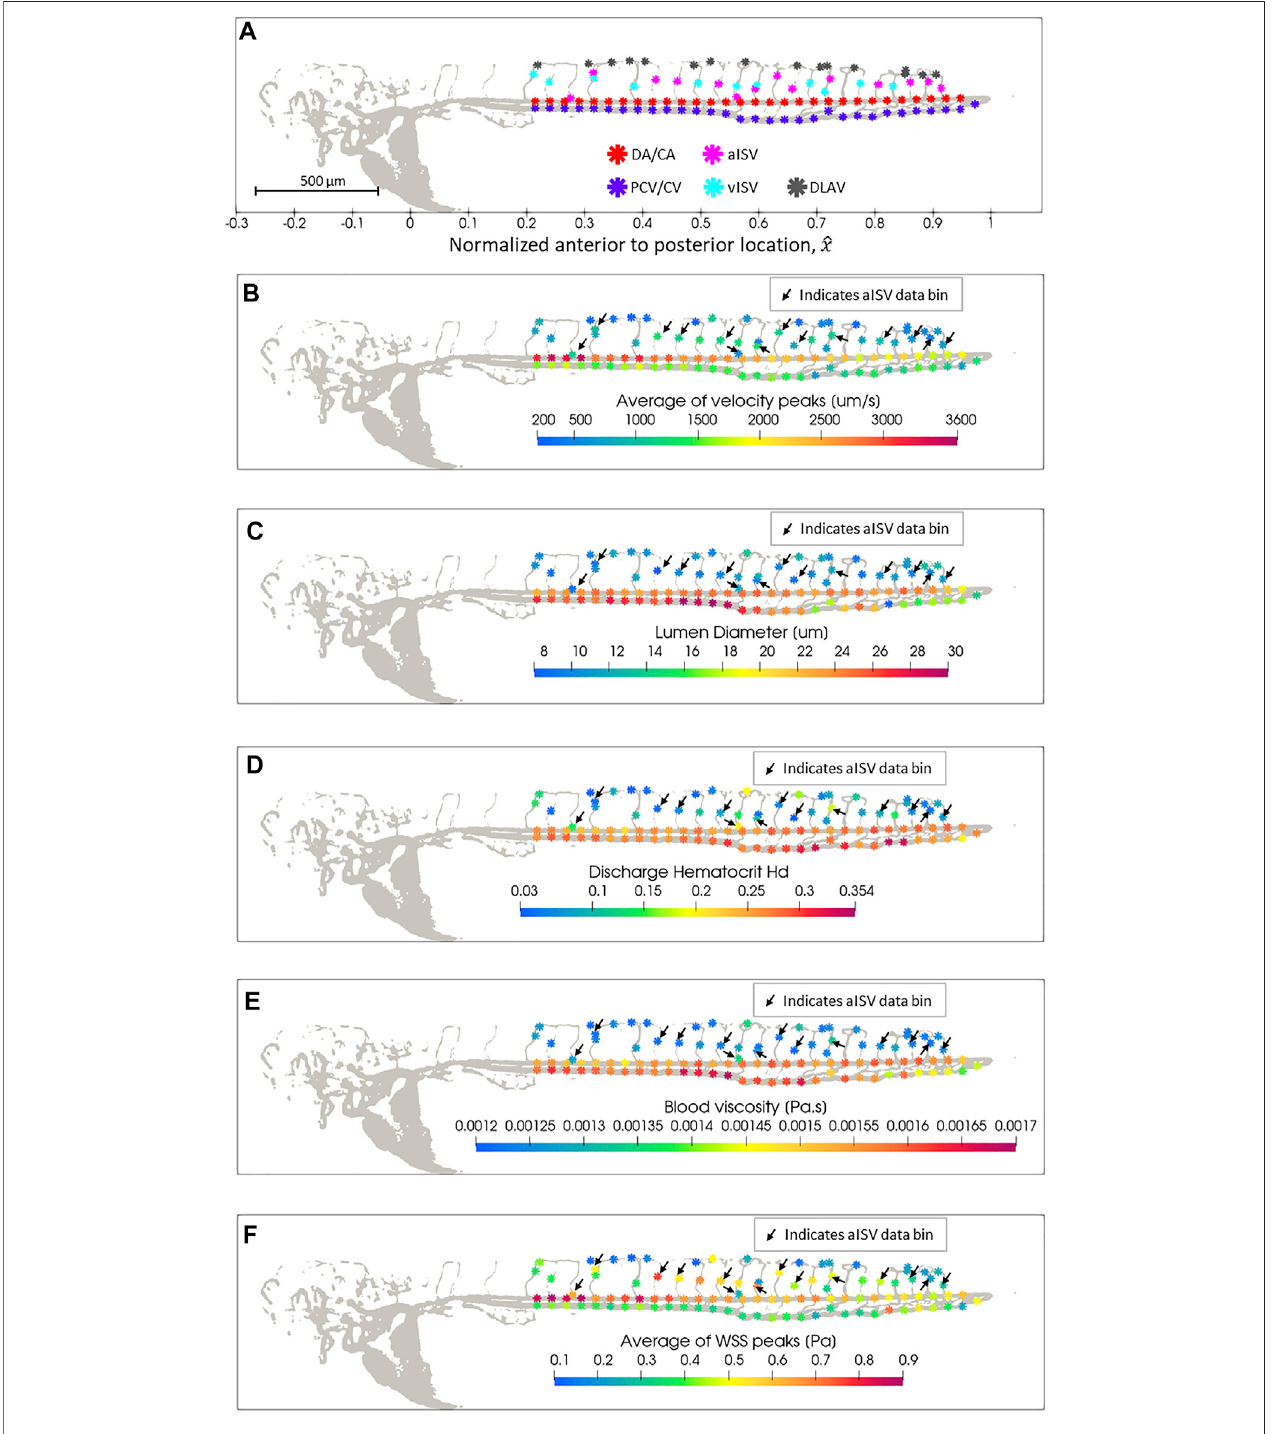
FIGURE 3 | Spatial distribution map of data in zebra fi sh 28 of the 2 dpf data set after automated spatial bin averaging: (A) vessel type, (B) average velocity peak ( V peak ), (C) lumen diameter ( D ), (D) discharge hematocrit ( H d ), (E) apparent blood viscosity ( η ) and (F) average peak WSS ( WSS peak ). Arrows in Panels (B – F) indicate the aISV data. See Supplementary Video S13 for maps of hemodynamic quantities for all zebra fi sh across all the developmental stages analyzed.